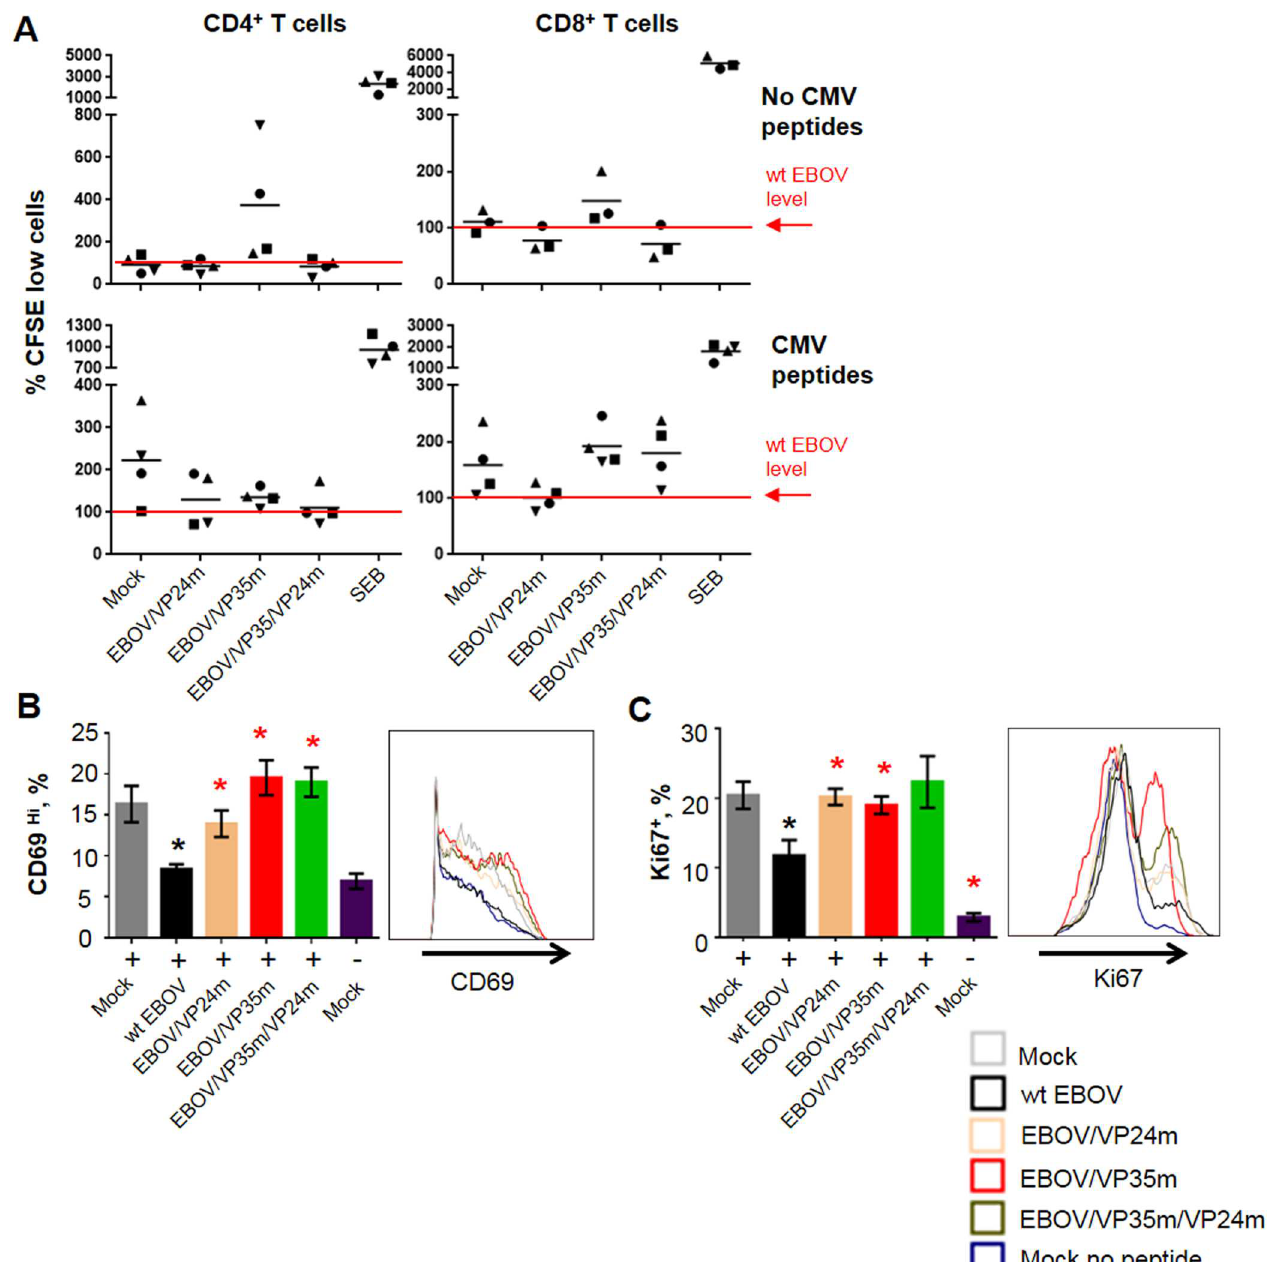
Fig 7. Effects of the VP35 and VP24 IID on proliferation of T cells. A , Proliferated CD4 + and CD8 + T cells analyzedby CFSE dilution assay, percentagesof CFSE low cells. Data for the mutated viruses are individually normalized to wt EBOV-infected cell levels in the same donor. Values for each of the 4 donorsanalyzedare indicatedwith individualsymbols. Mean values for each treatment are indicatedby horizontal bars. B , C . ExpandedCD4 + T cell CMV-responders culturedwith autologous CMV pulsed DCs: % of CD69 Hi cells (B) and Ki67 Hi CD4 + T cells (C) with representativeprimary data. Mean values with SE basedon 3 donors/experiments. A, No statistically significantdifferences, B, C, statistically significantdifferences (P < 0.05)for wt EBOV as compared to mock are indicatedwith black asterisks, and for the mutated viruses as compared to wt EBOV with red